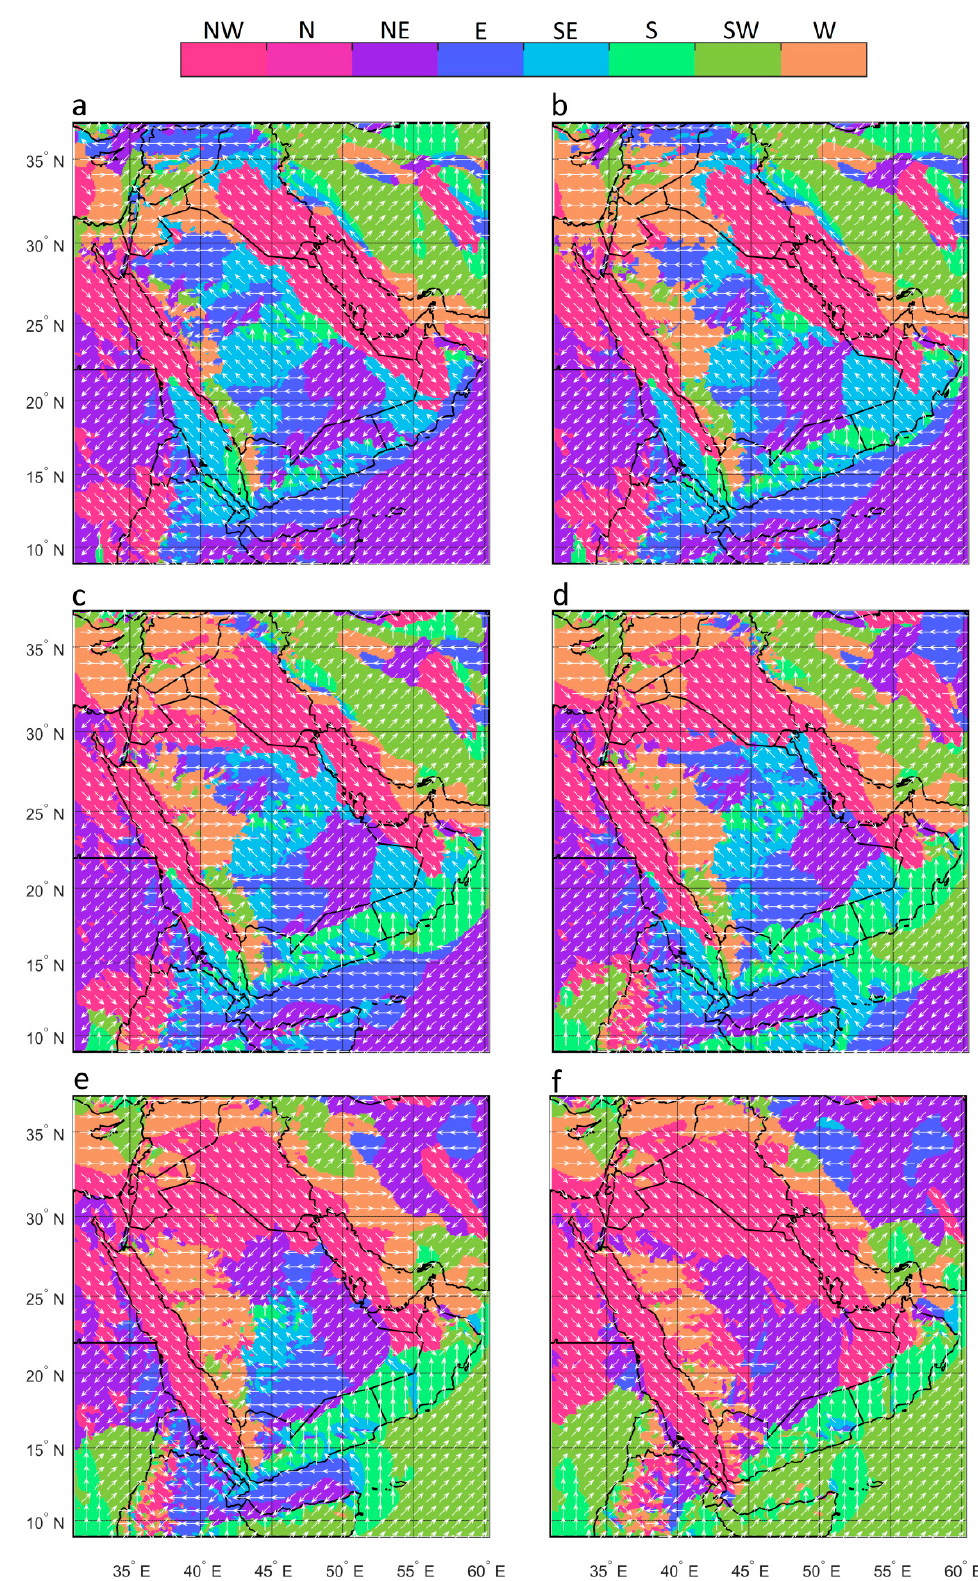
Figure 13. Prevailing wind speed directions from January to June ( a – f ).